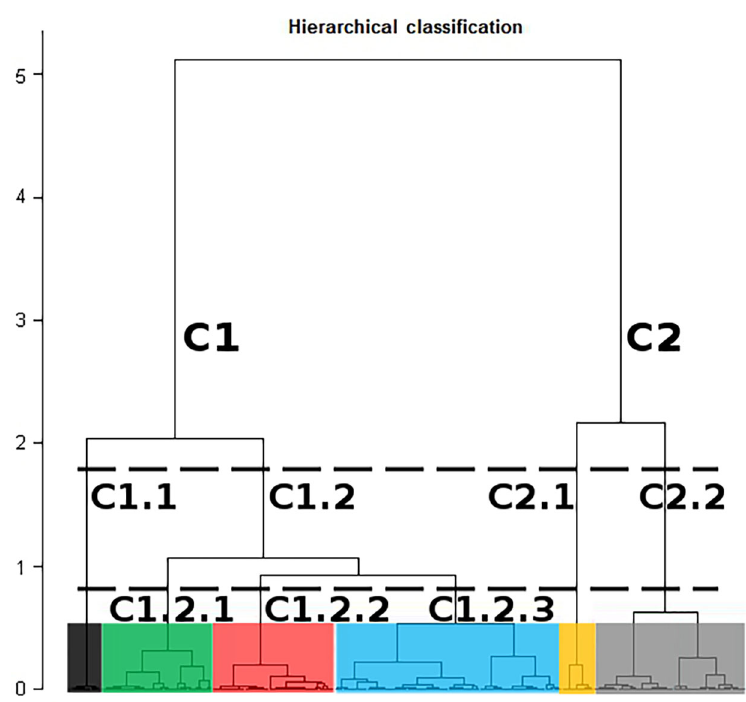
Fig. 6. Hierarchical classification dendrogram. The distance of linkage between samples/clusters is a measure of similarity of individual samples within the cluster or between clusters. The most distant linkage bonds two groups of samples that are further subdivided and samples can be described by a distinguishing component: C1.1 – dolomite (MgO); C1.2.1 – apatite (P 2 O 5 ); C1.2.2 – calcite (CaO); C1.2.3 – ‘average oil shale’; C2.1 – organic matter (OM, S, trace metals); C2.2 – silicate (clay-relate d elements). For the full pattern of 18 elements see Fig. 7. Note that the diagram reflects the number of samples and also the number of varieties in the clusters that are described in the